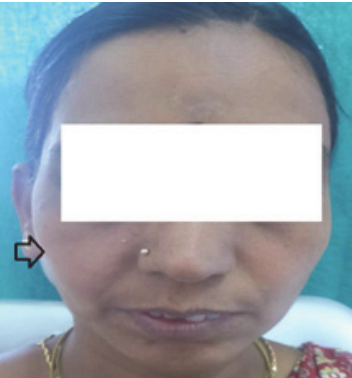
Figure 1: Extraoral swelling present on the right side infraorbital region.